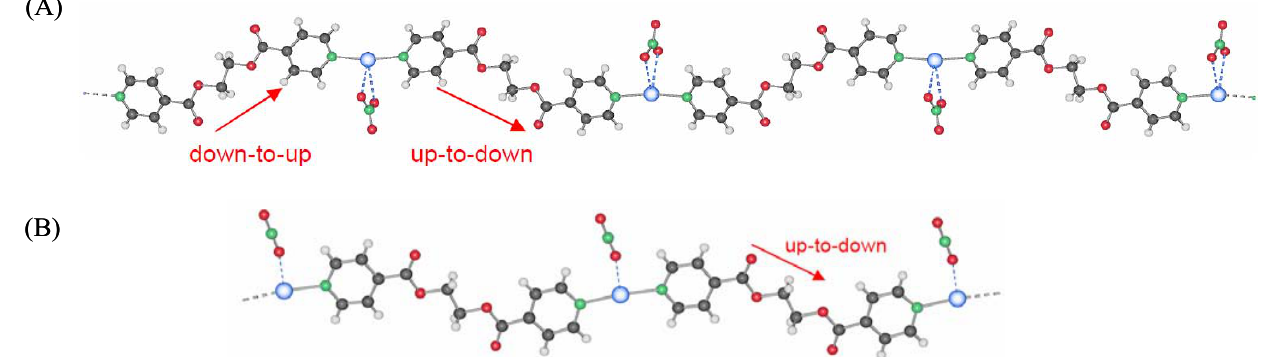
] , ( A ) compound 1 , ( B ) compound 2 [12-18]; 3 n